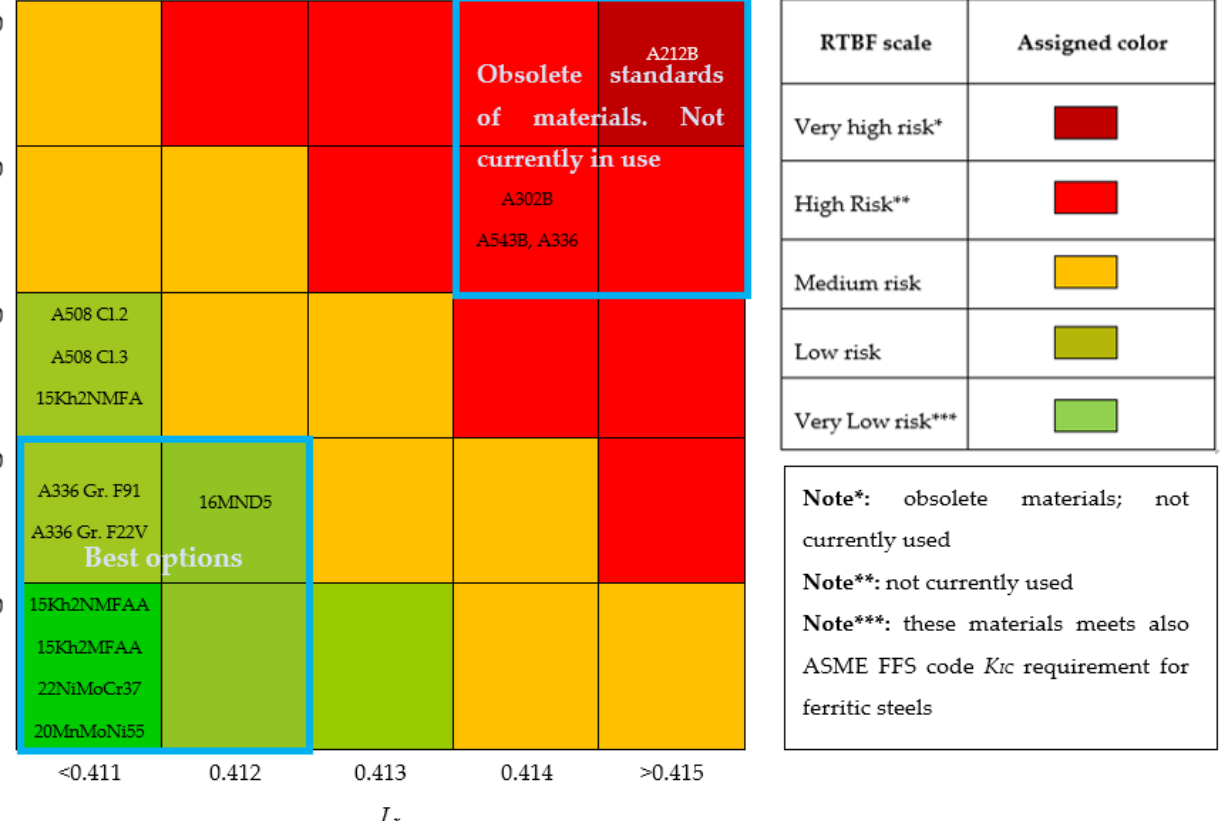
Figure 6. Risk matrix according to